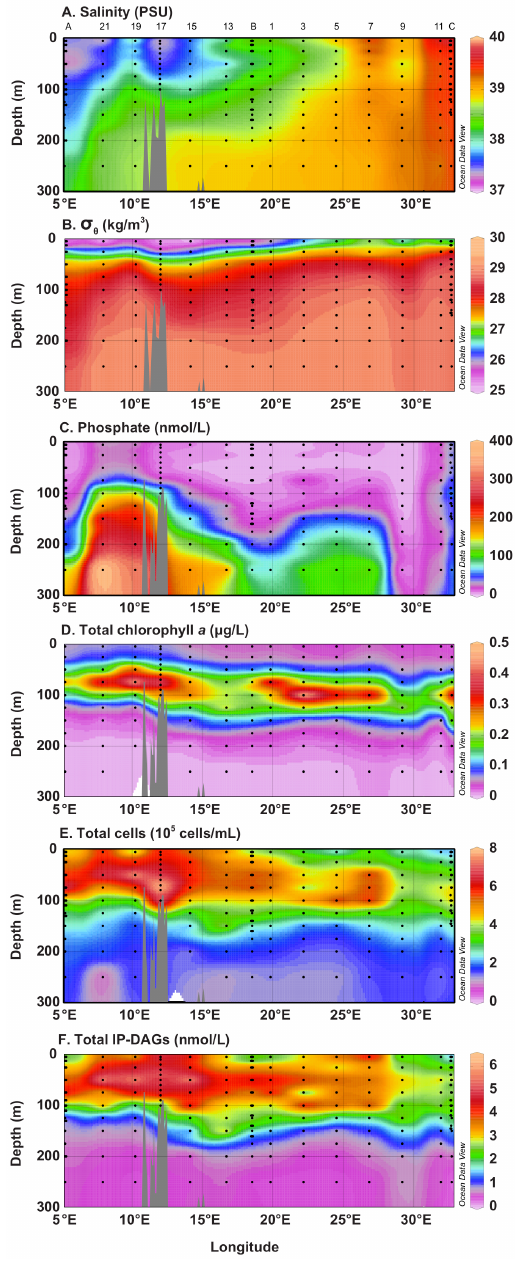
Fig. 2. Distribution of several parameters measured in the upper water column (300m) from west to east across the Mediterranean Sea. Salinity (A) and potential density ( σ θ ; B ) were measured with the CTD sensors; phosphate (C) is soluble reactive phosphorus as measured by an autoanalyzer instrument; total chlorophyll- a (D) is the sum of chlorophyll- a , divinyl chlorophyll- a and chlorophyllide- a ; total cells (E) is the sum of Prochlorococcus , Synechococ- cus , heterotrophic bacteria, picoeukaryotic phytoplankton, and na- noeukaryotic phytoplankton; total IP-DAGs (F) is the sum of the nine most abundant classes of IP-DAGs found in the water col- umn. Numbers across the top panel indicate station labels; black dots indicate individual samples, colored contours indicate interpo- lated